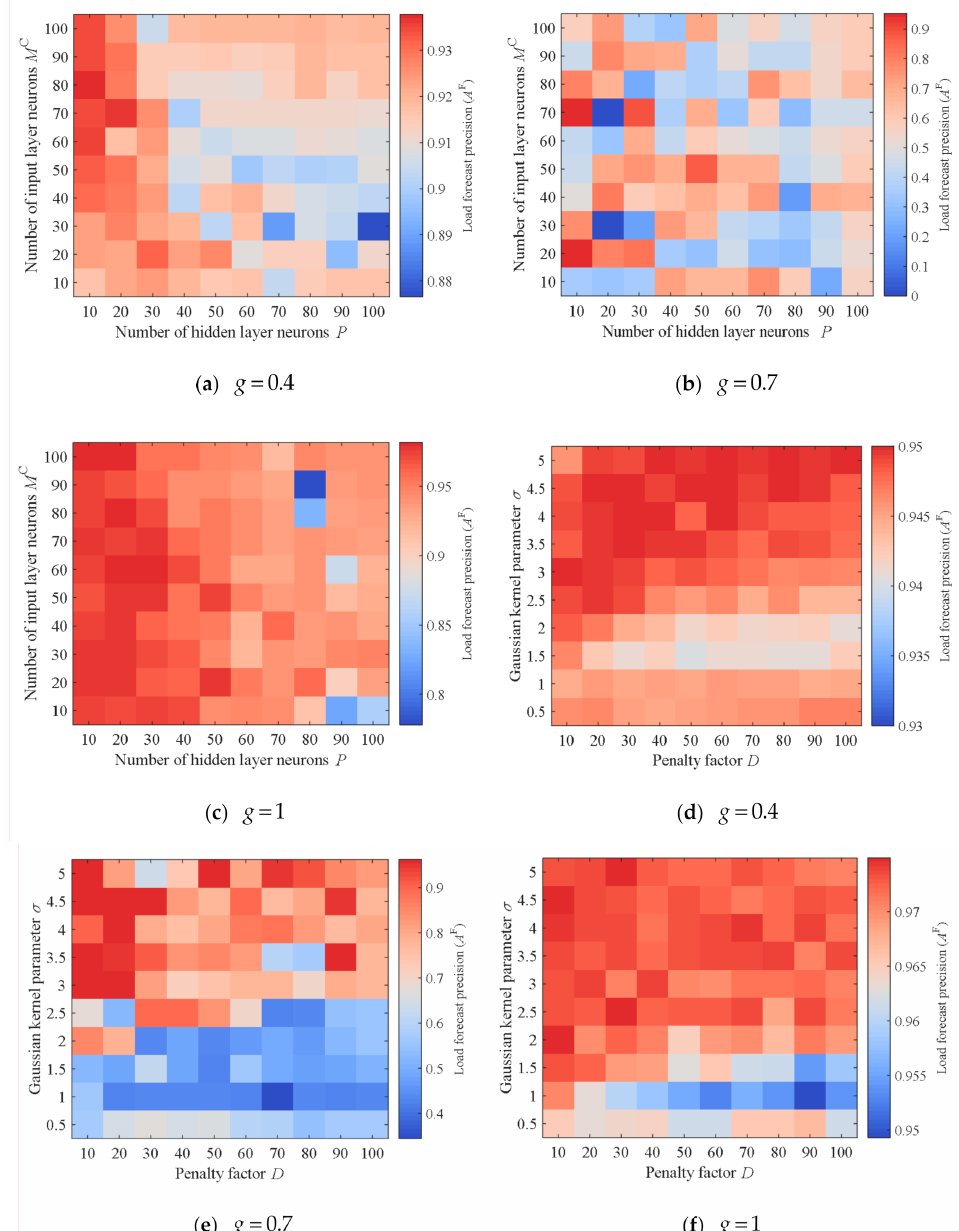
Figure 5. Load forecast precisions of neural network and support vector machine under different parameter combinations: ( a ) Load forecast precisions under different combinations of P and M C when g = 0.4; ( b ) Load forecast precisions under different combinations of P and M C when g = 0.7; ( c ) Load forecast precisions under different combinations of P and M C when g = 1; ( d ) Load forecast precisions under different combinations of D and σ when g = 0.4; ( e ) Load forecast precisions under different combinations of D and σ when g = 0.7; ( f ) Load forecast precisions under different combinations of D and σ when g =